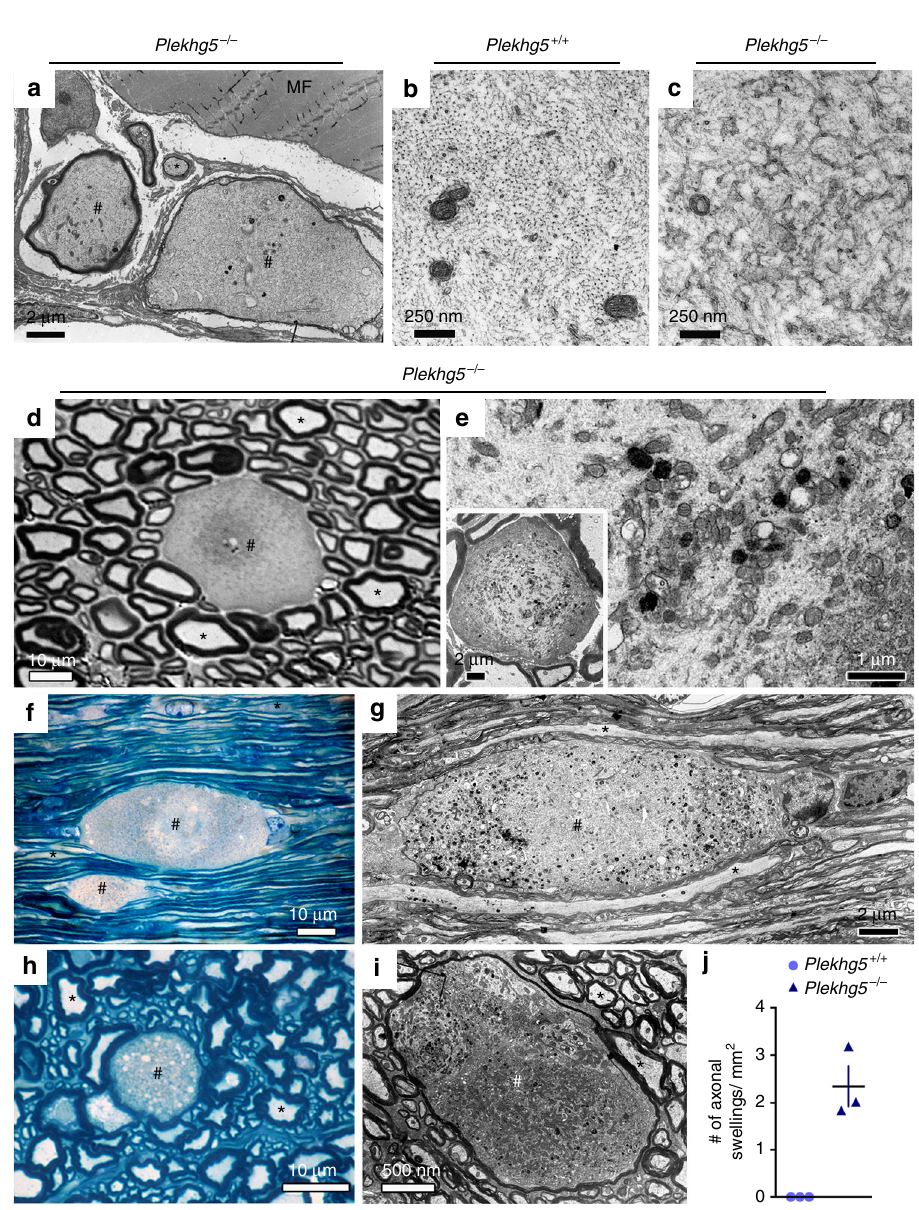
Fig. 4 Loss of Plekhg5 impairs axonal integrity. a Swellings in distal motor axons. MF, muscle fi ber. Scale bar : 2 µ m. b , c High magni fi cation micrographs of axons from wild-type b and Plekhg5-de fi cient c mice with altered cytoskeleton organization in Plekhg5 − / − mice. Scale bar : 250 nm. d Semi-thin cross-section of sciatic nerve from Plekhg5-de fi cient mice showing an axonal swelling. Scale bar : 10 µ m. e High magni fi cation micrograph of an axonal swelling from sciatic nerve. Scale bar : 1 µ m. Inset , Scale bar : 2 µ m. f – i Longitudinal- f , g and cross- h , i sections of lumbar spinal cord showing axonal swellings within the white matter of Plekhg5 − / − mice. f , h Scale bar : 10 µ m. g , i Fine structure of axonal swellings in spinal cord white matter of Plekhg5- de fi cient mice. # labels axon swellings; asterisks label axons with unaltered morphology. g Scale bar : 2 µ m. h Scale bar : 10 µ m. i Scale bar : 500 nm. j Quanti fi cation of axonal swellings in spinal cord semi-thin cross-sections. Three animals per genotype were analyzed. Each data point represents the mean of 10 sections from individual animals with a distance of 100 µ m between each